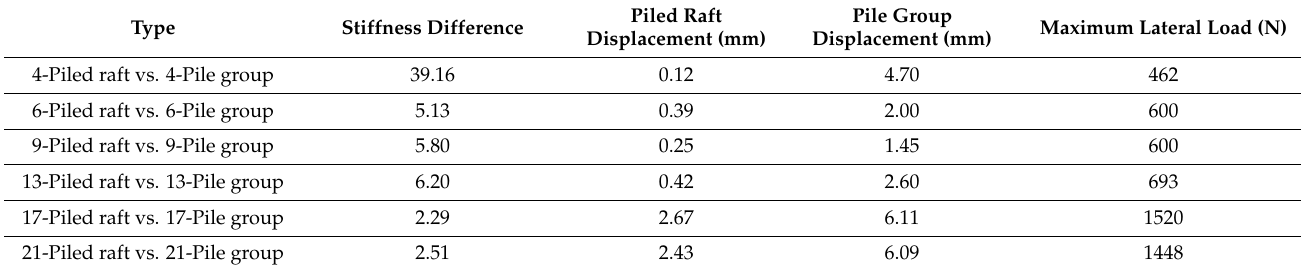
Table 2. Stiffness difference in pile group vs. pile raft under lateral load.